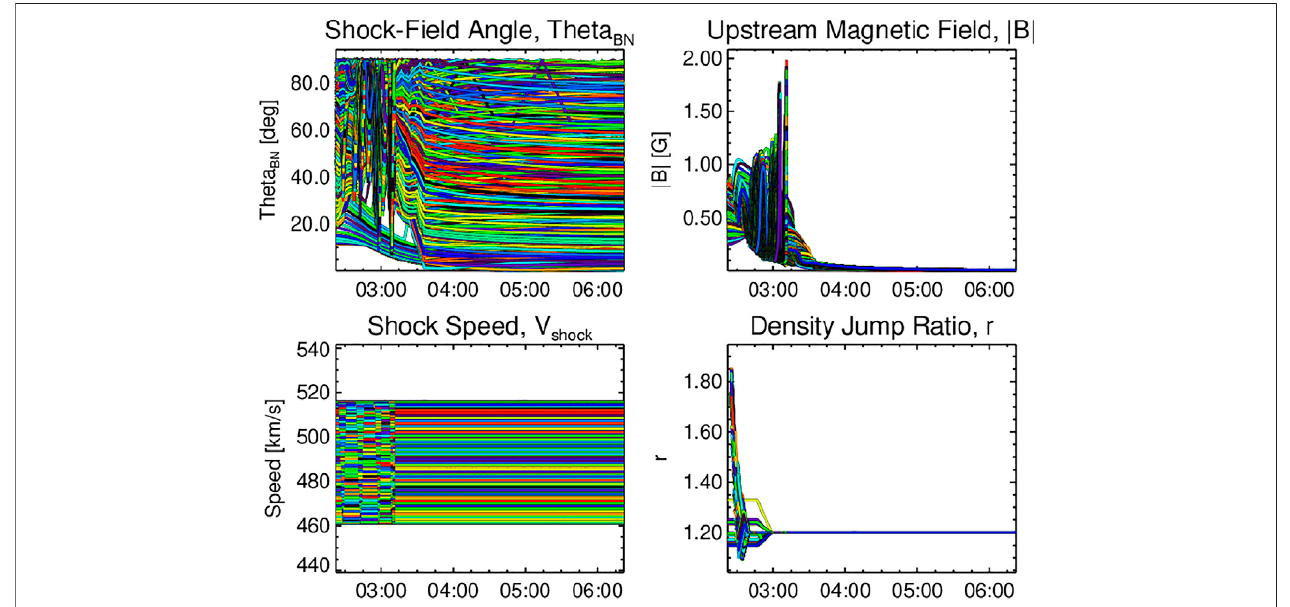
FIGURE 4 | Time series of the main parameters used for diffusive shock acceleration modeling, estimated at all shock-crossing fi eld lines for the May 11, 2011 event.Notethatthedensityjumpratio, r ,issetto1.2(representingaweakshock)beyondthe fi eldofviewofAIA.Thedifferentcolorsareonlyusedtodiscernbetweenthe separate shock-crossing points, and do not carry any additional meaning in this